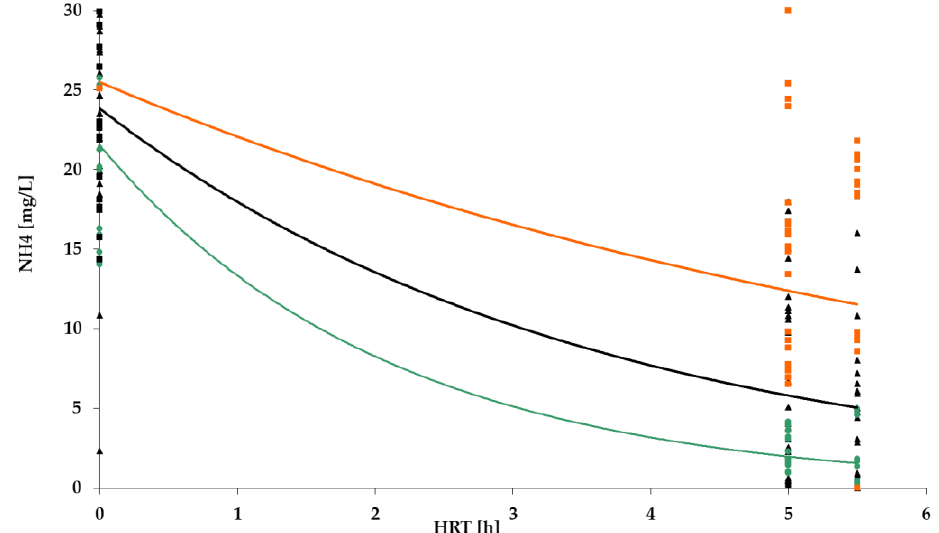
Figure 10. NH 4 removal dynamics for: PS floating carrier (black); PV floating carrier (green); BB floating carrier (orange).